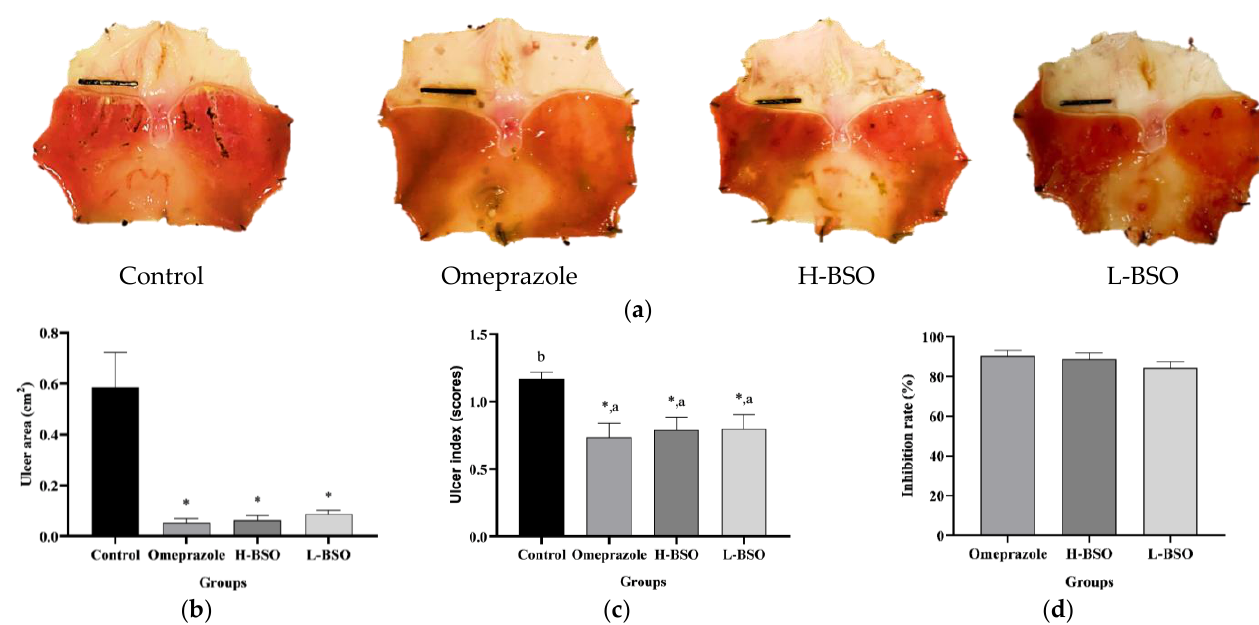
Figure 1. Gross gastric lesions ( a ), ulcer gastric areas ( b ), ulcer index score ( c ), and percentage of inhibition rate ( d ) in rats with ethanol-induced gastric ulcers pretreated with distilled water, omeprazole, 100% black seed oil (H-BSO), and 50% black seed oil (L-HSO). * Significantly different from the control at p < 0.05. Different letters ( a–b ) indicate significant differences ( p < 0.05) between groups determined by Duncan’s multiple-range test. Scale bar = 1 cm.